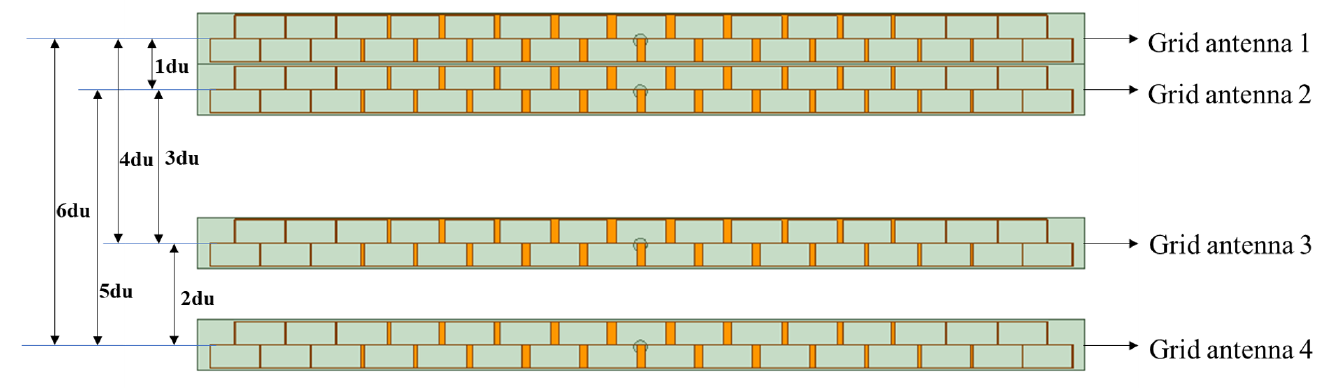
Figure 5. One-dimensional non-redundant sparse array composed of four microstrip grid antennas.